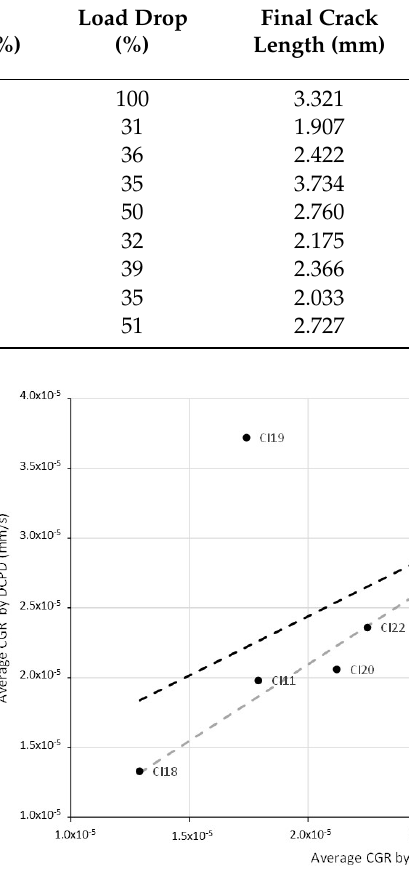
Figure 8. Correlation between DCPD estimation and measurement of striations spacing for the different specimens.